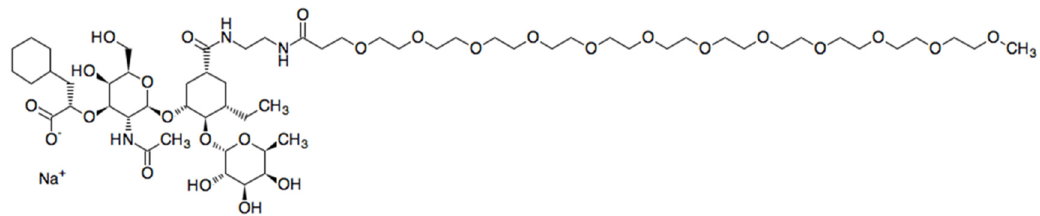
Figure 1. Chemical structure of uproleselan.